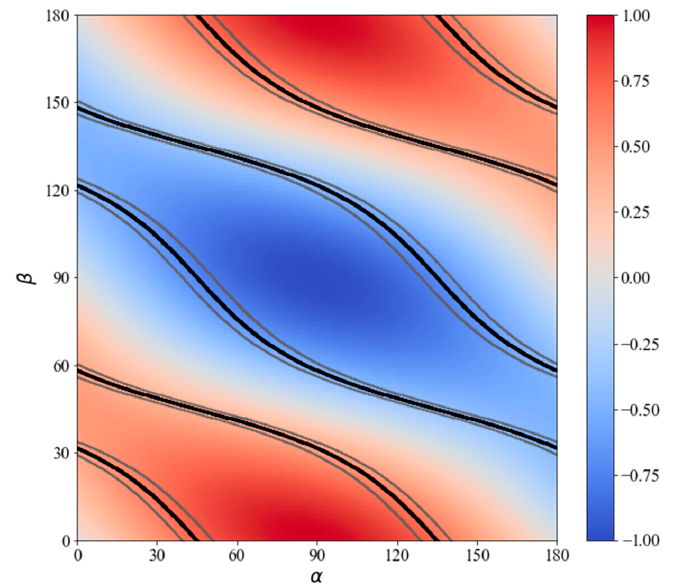
Figure 1. Dependence of the measured signal on the terahertz and probe radiation polarization angles ( α and β , respectively) relative to the z -axis of the (110)-cut zincblende detection crystal. In our study, instead of aiming to adjust the electro-optic detection system to achieve the maximum absolute value of F ( α , β ), we seek values of angles α and β providing the same sensitivity for two orthogonal terahertz polarizations, i.e., pairs of α satisfying the condition α 2 − α 1 = 90°. For each fixed β in Equation (2), we find pairs of orthogonal α that provide the same sensitivity (see the black curves in Figure 1). The absolute values of F 110 ( α , β ) on the found curves vary from √2/4 to √2/2 . The grey curves in Figure 1 rep- resent a 10% deviation bound of the optimum value. The highest absolute value of |𝐹 (cid:2869)(cid:2869)(cid:2868)(cid:3040)(cid:3028)(cid:3051) | = √(cid:2870) (cid:2870) (cid:3406) 0.71 is achieved at angles β = 0° or 90° for two orthogonal terahertz polarization angles, α 1 = 45° and α 2 = 135° ( − 45°), simultane- ously. The optimum value of F 110 changes by less than 10% within the range of α = 39.52° − 51.06°. We can perform a similar analysis for (111)-cut zincblende crystals that are also used in THz-TDS. The formula from [13] can be applied for the particular case of a (111)-cut detection crystal to calculate the function F 111 ( α , β ), as follows: 𝐹 (cid:2869)(cid:2869)(cid:2869) (cid:4666)𝛼,𝛽(cid:4667) = (cid:3496) 2 3 sin(cid:4666)𝛼 + 2𝛽(cid:4667) (3) where α and β are angles between the ( − 211)-axis of the detection crystal and the polari- zation direction of terahertz and probe radiation, respectively. The function F 111 ( α , β ) is depicted in Figure 2. The maximum absolute value of |𝐹 (cid:2869)(cid:2869)(cid:2869)(cid:3040)(cid:3028)(cid:3051) | = (cid:3495) (cid:2870) (cid:2871) (cid:3406) 0.82 is achieved at α = 90° and β = 0° or 90° too. However, in contrast to the case of (110)-cut crystal, the same maximum absolute value of |𝐹 (cid:2869)(cid:2869)(cid:2869)(cid:3040)(cid:3028)(cid:3051) | is also achieved at a set of angles α and β satisfying the following condition: 𝛼 + 2𝛽 = 90° + 180°𝑛 , where n is an integer value.